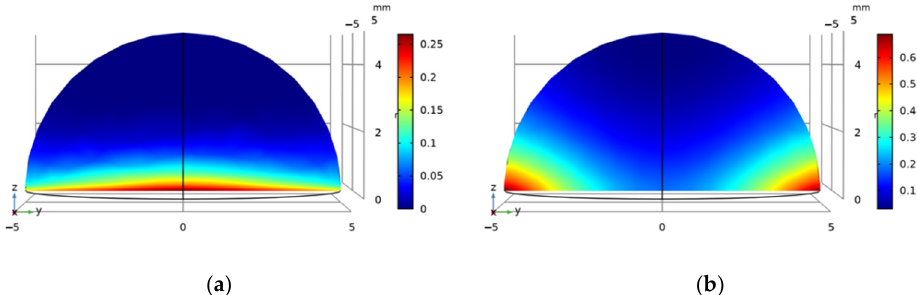
Figure 7. ( a ) Ferrous ion formation, ( b ) hydroxyl ion concentration profile in the drop in mol m − 3 .